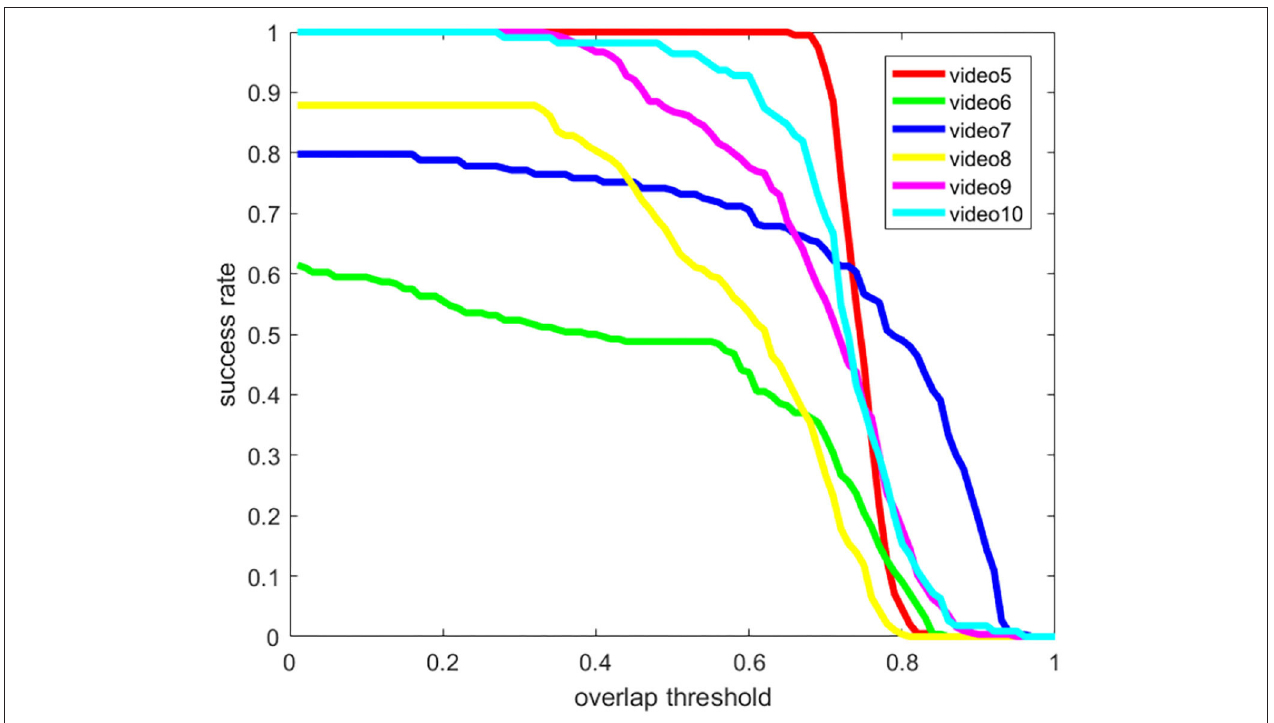
FIGURE 15 | The success rate of public